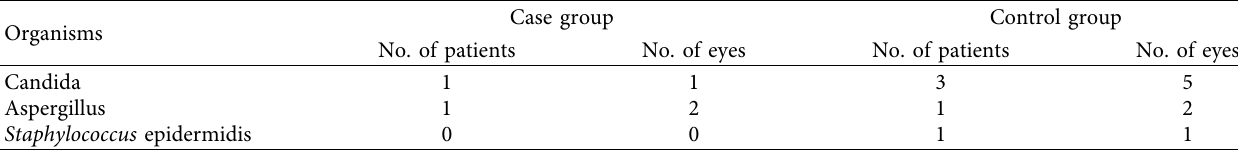
Table 2: Comparison of microbiology of EE patients with and without COVID-19.